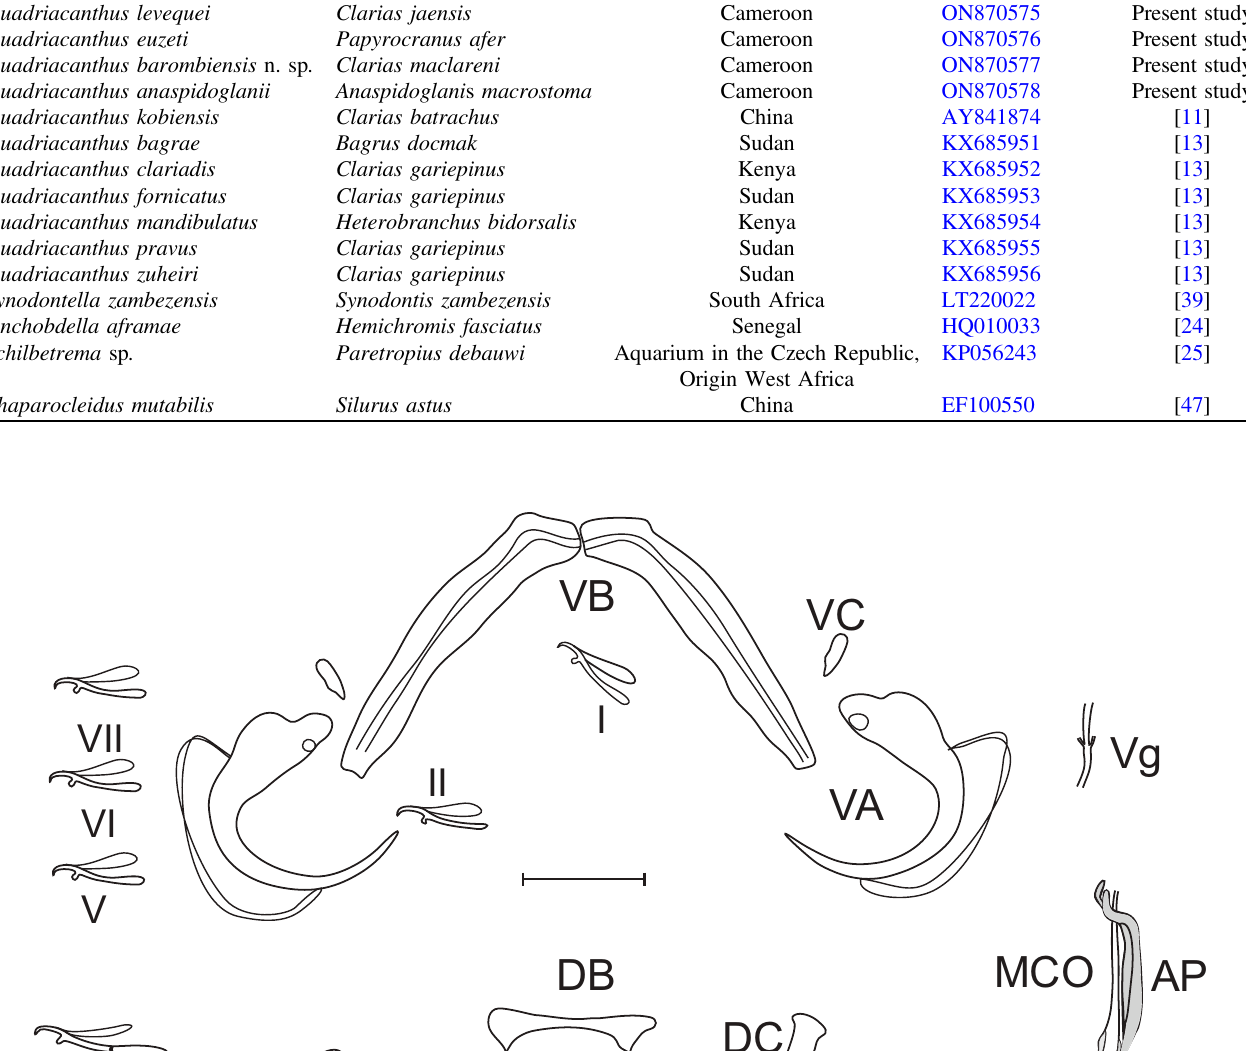
Seven pairs of hooks, pair IV with short handle, larger than pairs I, II, III, V, VI and VII, the latter pairs about subequal. Tubular male copulatory organ (MCO) enlarged at its basal zone and tapered at distal extremity. Accessory piece straight, slightly curved distally and ending in two small, rounded hooks, one